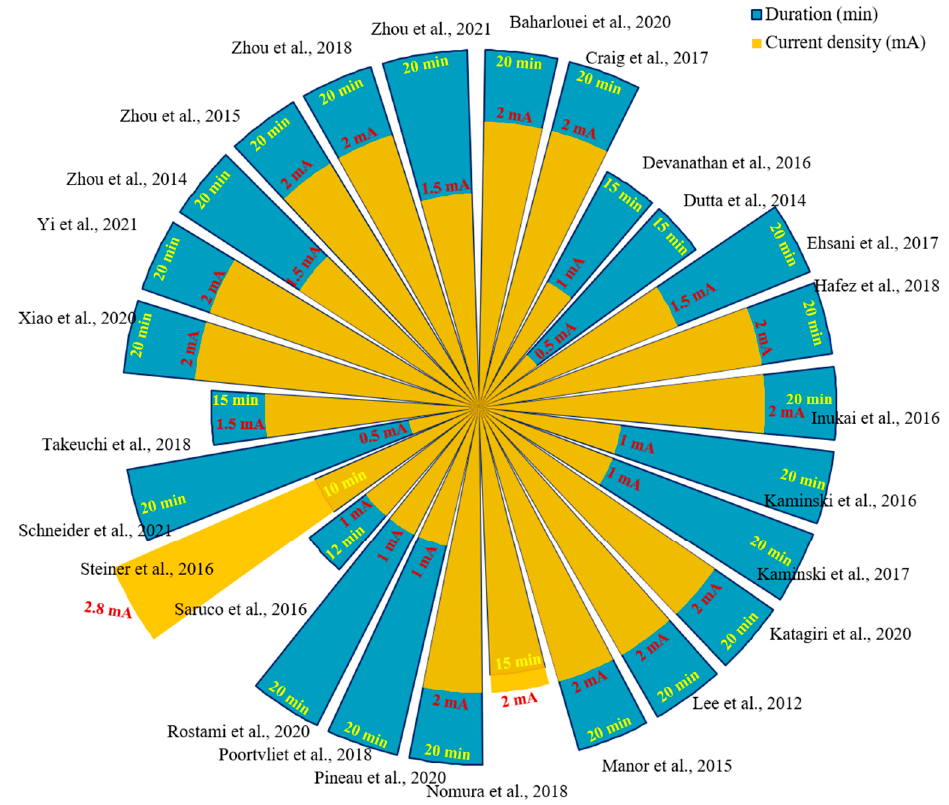
Figure 3. Stimulation duration and intensity in included studies